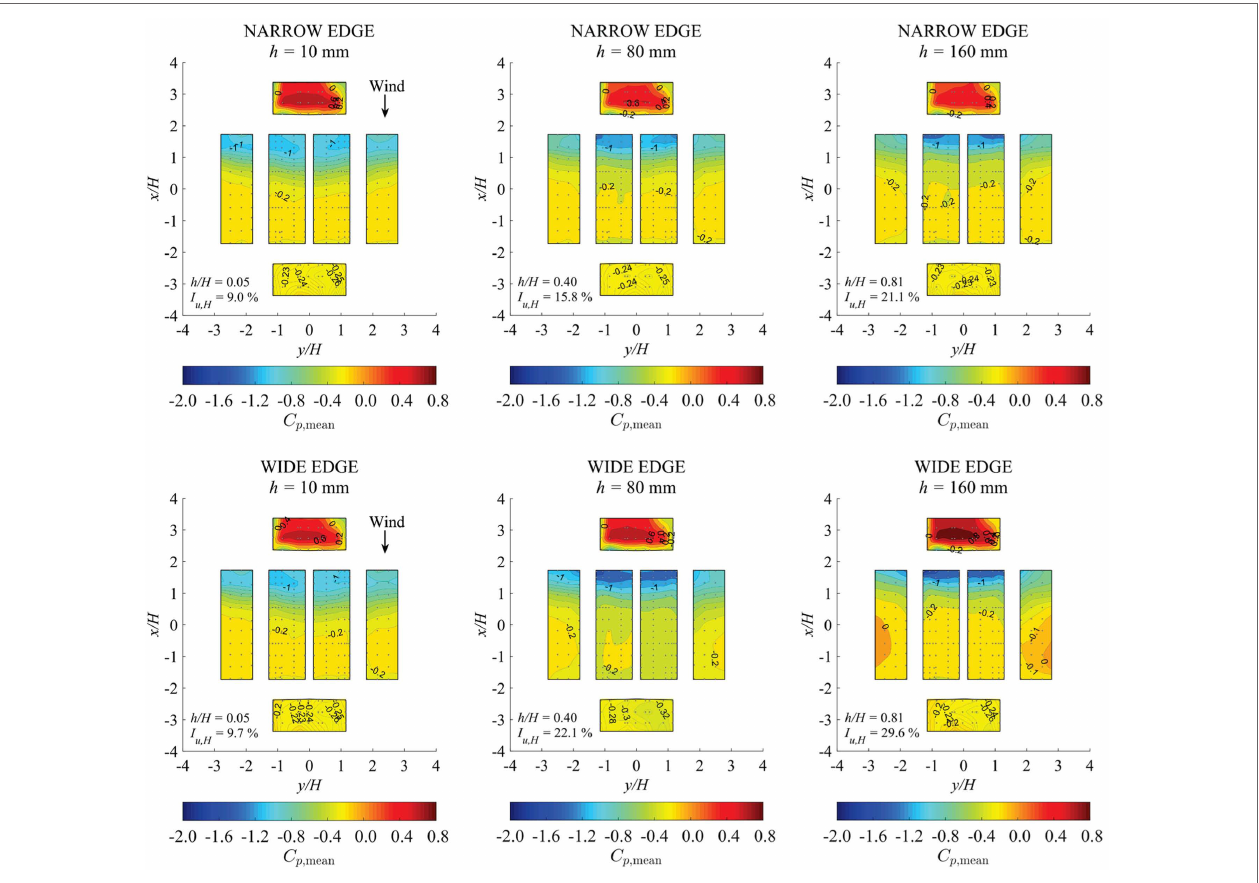
FIGURE 7 | Contours of mean pressure coefficients referenced to the mean velocity pressure at the eave height of the 1:20 model of the Wind Engineering Research Field Laboratory